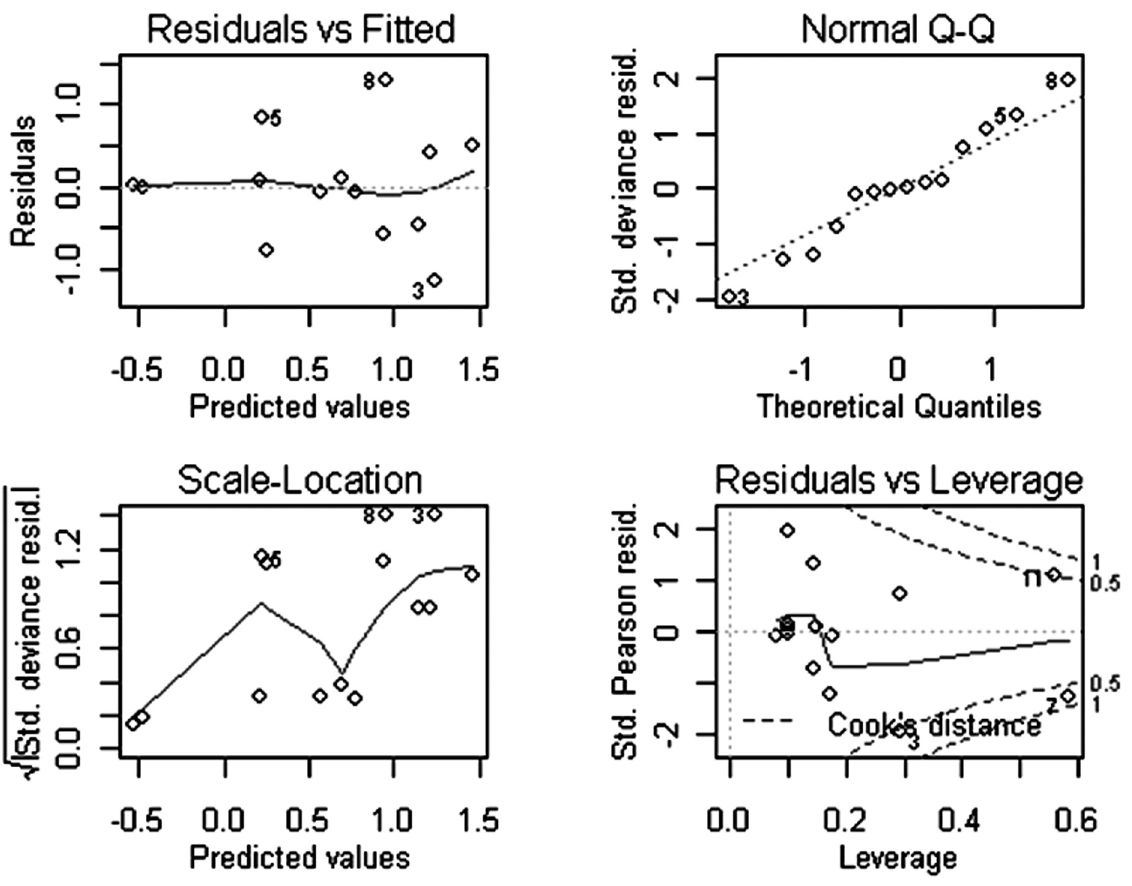
Fig . 7. – residual plots of the main effects model fitted to percentage of discards in weight (gaussian family log Table 8. – coefficient estimates and their standard errors. t value and the p-value of the null hypothesis (the parameter=0) test of the model fitted to the percentage of discards in weight estimate std. error